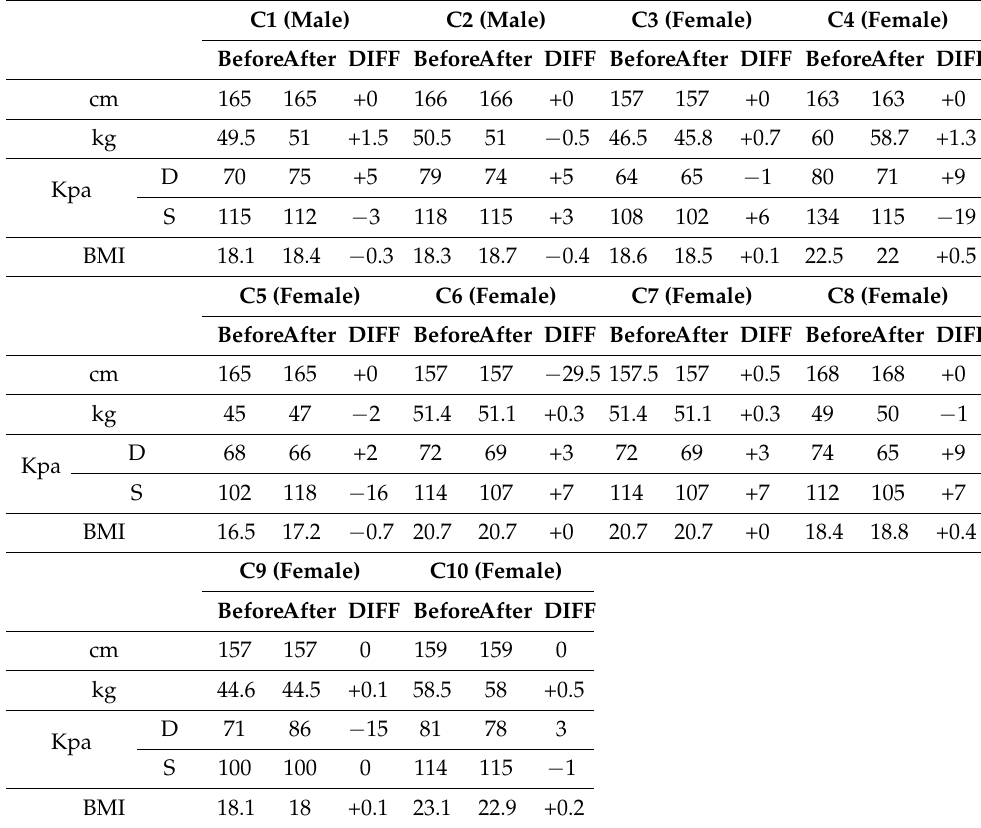
Table 6. Statistical comparison of body quality and physical fitness of subjects in the control group before and after the